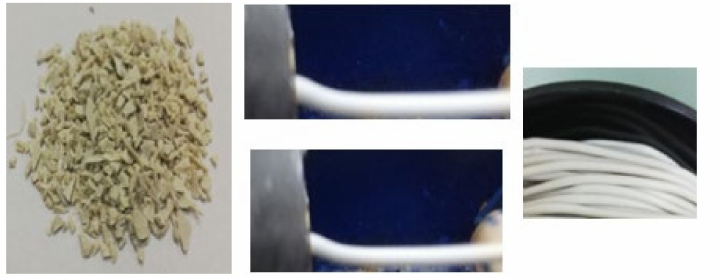
Figure 11. Shaping of selected racemic nucleated selected compound into 3D printing